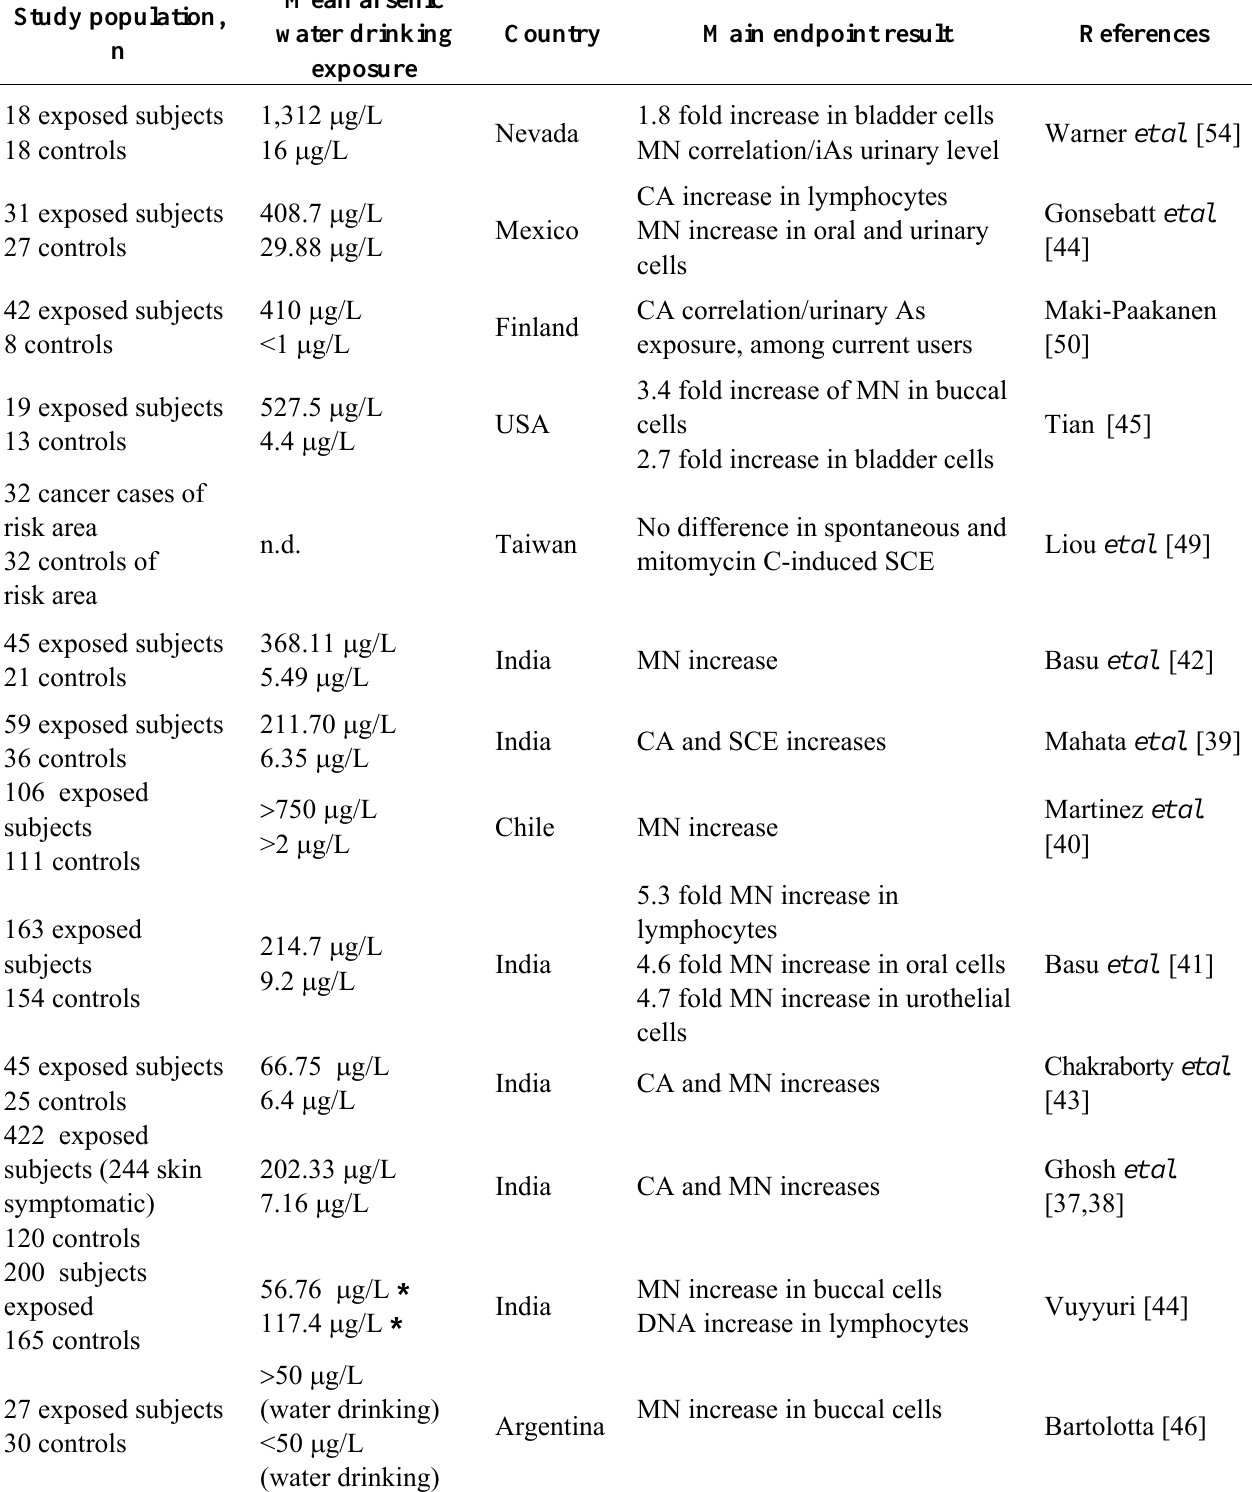
Table 1. Cytogenetic monitoring in populations exposed to